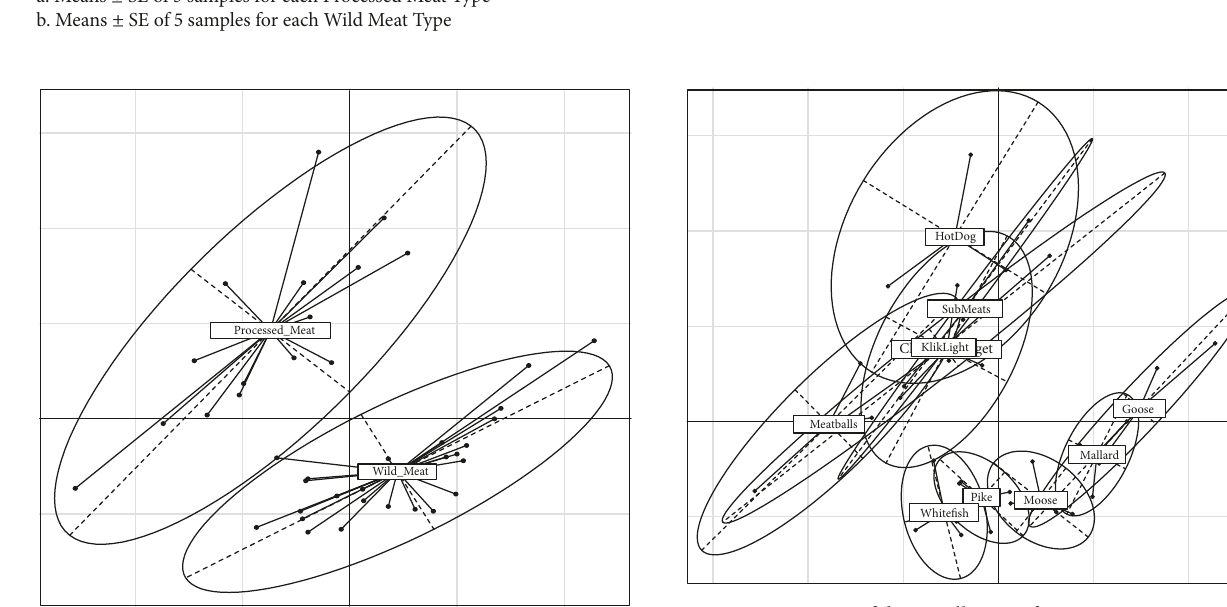
Figure 2: 95% Confidence Ellipses of 19 AAs on PC-1 vs PC-2 Distinguish Processed a Meat Types and Wild Meat Types. a. The Klik Light label partially obscures the Chicken Nugget